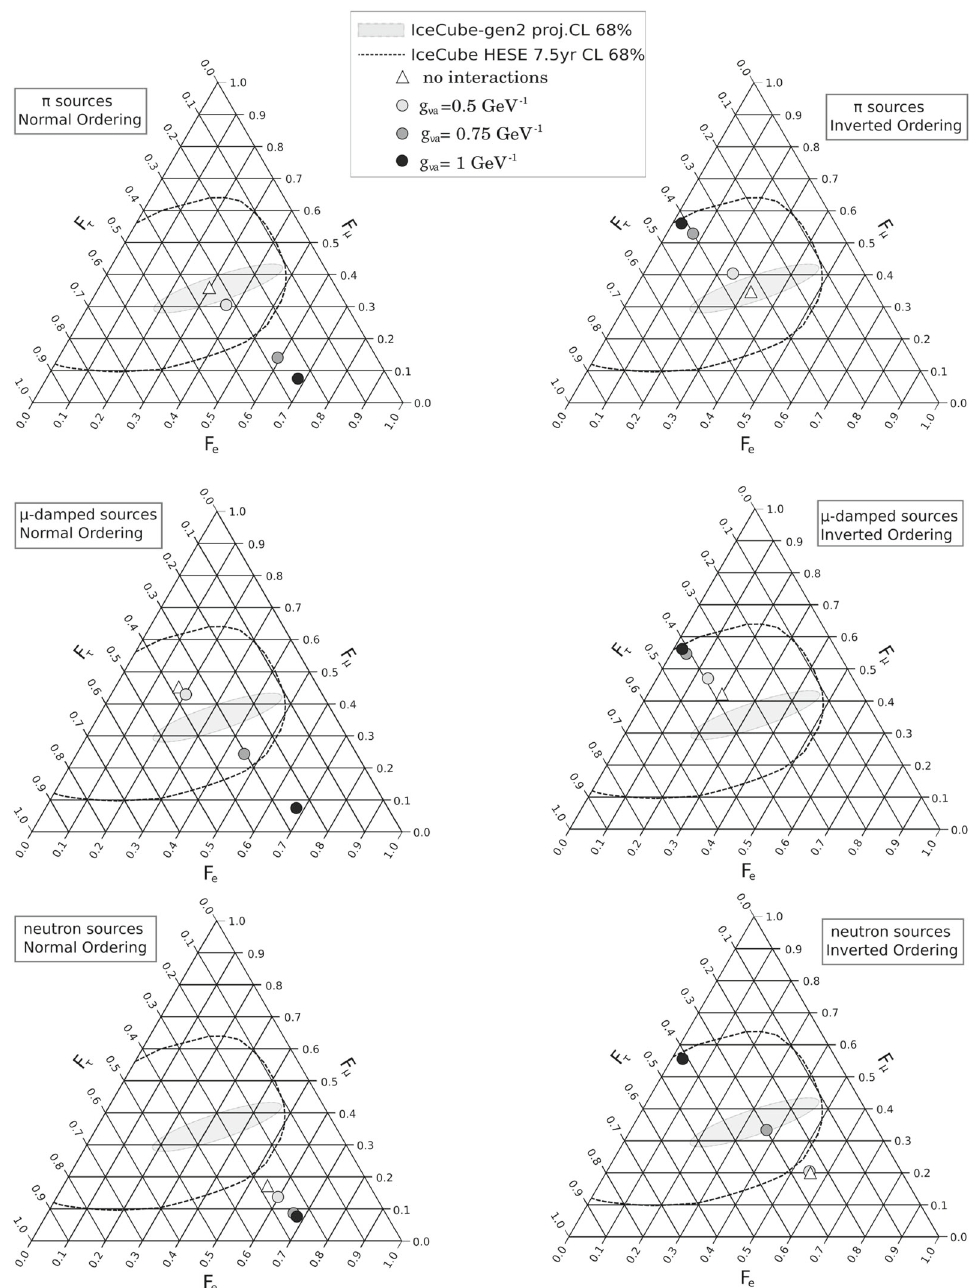
Fig. 11 Ternary plots of the flavor ratios for neutrinos above E min = 5 × 10 5 GeV in the NO case (left plots) and in the IO case (right plots) under the assumptions of pion decay sources (upper panels), muon damped sources (middle panels), and neutron decay sources (bottom panels). The outcomes expected in the absence of neutrino interac- tions are marked by white triangles, while the results with interactions enabled are shown in gray squares for g ν a = 0 . 5 GeV − 1 , in dark gray